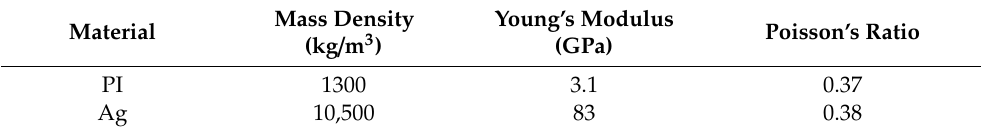
Figure 4. The simulation results of PVDF based monolayer structure. ( a ) Simulation model built in COMSOL Multiphysics 5.3; ( b ) vibration mode shape at the resonant frequency of 126.16 kHz. 3. Fabrication Process